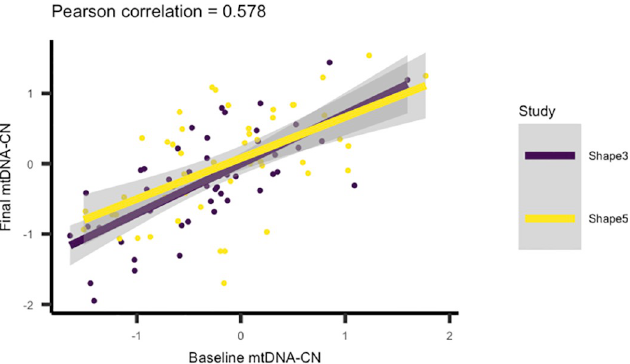
Fig 2. Strong correlations between baseline and final mtDNA-CN. Baseline (pre-intervention) and final (post- intervention) mtDNA-CN measurements taken six months apart are well-correlated, with a Pearson correlation of 0.578.